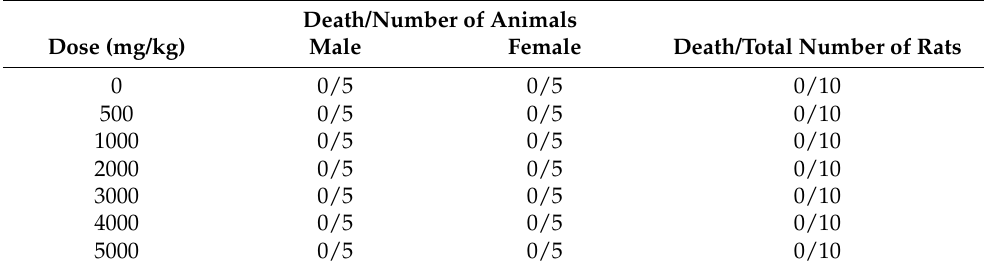
Table 2. Acute (oral) toxicity study of albino rats after 24 h oral administration of aqueous C. pepo leaf extract. Death/Number of Animals Dose (mg/kg) Male